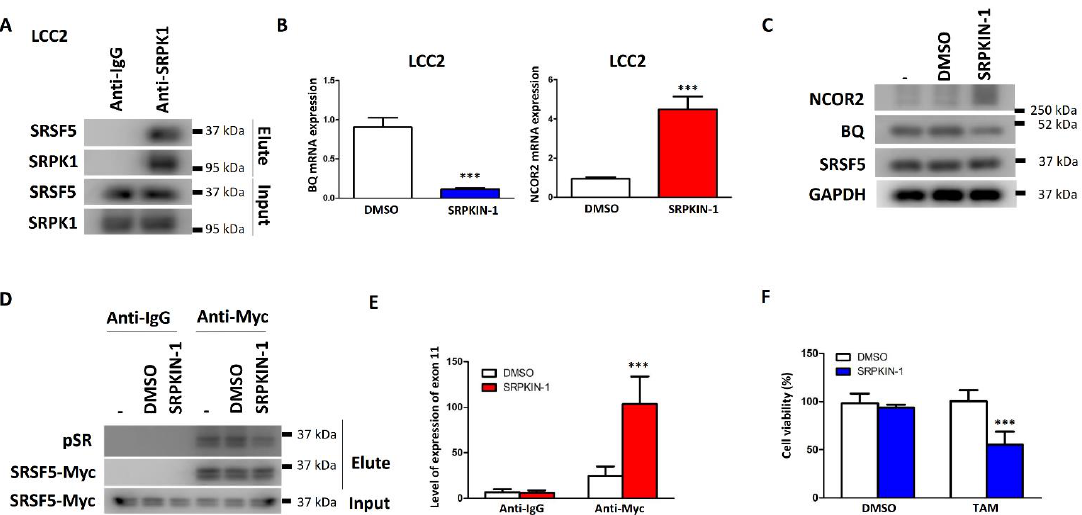
Figure 6. SRPKIN-1 could reverse TAM resistance by modulating the activity of SRSF5 Figure 6 . SRPKIN-1 could reverse TAM resistance by modulating the activity of SRSF5 towards exon